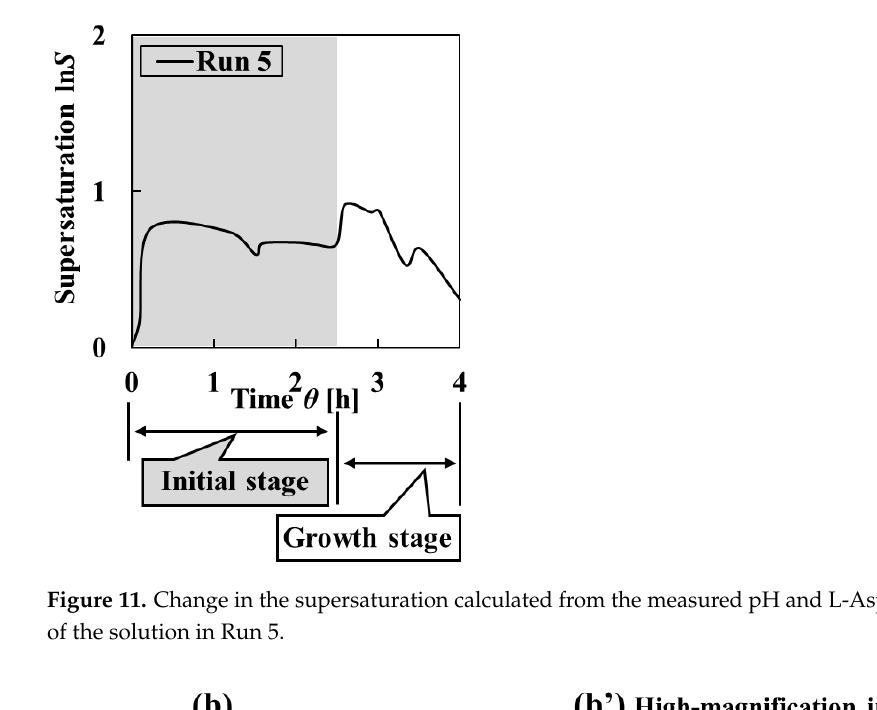
Figure 11. Change in the supersaturation calculated from the measured pH and L-Asp concentration of the solution in Run 5.